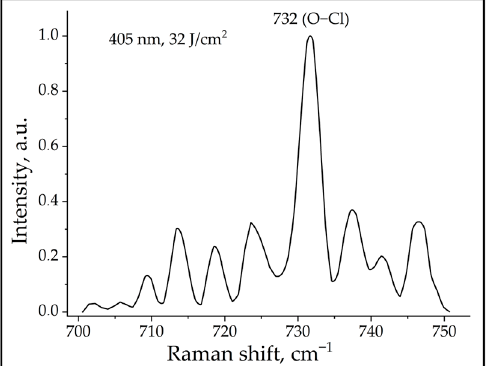
Figure 2. Raman spectrum of neutrophils exposed to radiation with a wavelength of 405 nm and a dose of 32 J/cm 2 . The characteristic Raman frequency of 732 cm − 1 for HClO can be